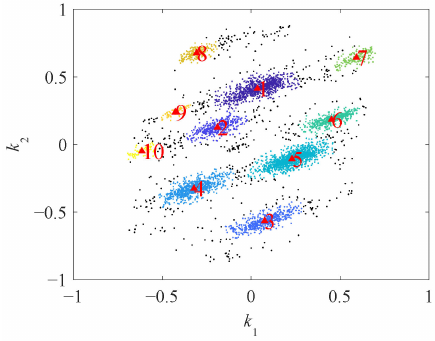
Figure 11. The clustering